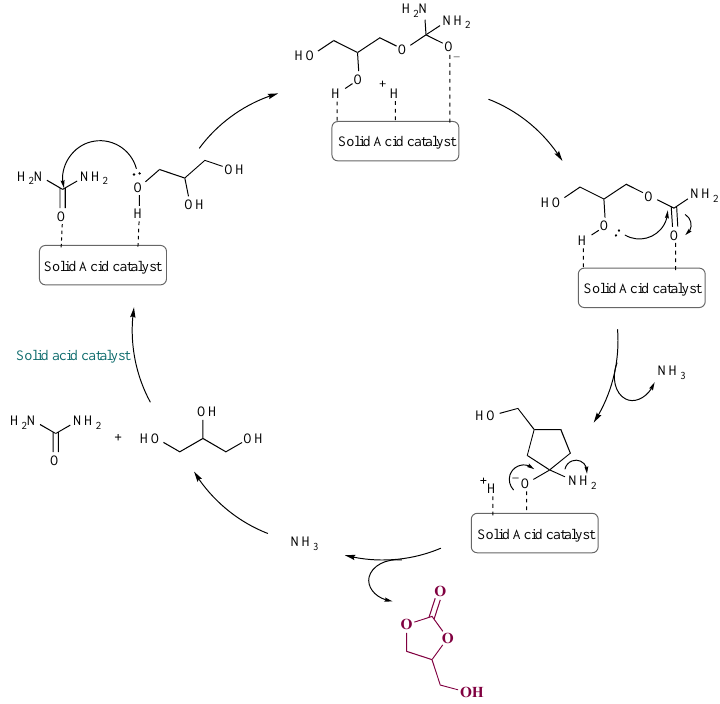
Scheme 5 . General mechanism of solid acid catalyst in the urea route to GC . Scheme 5. General mechanism of solid acid catalyst in the urea route to